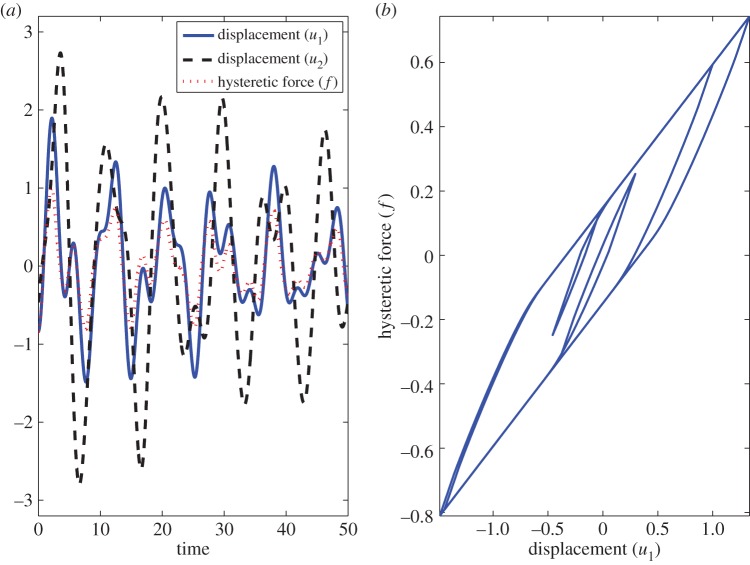
(a) Displacements u1, u2 and hysteretic force f versus time. (b) Hysteresis between u1 and f for a portion of the computed solution.